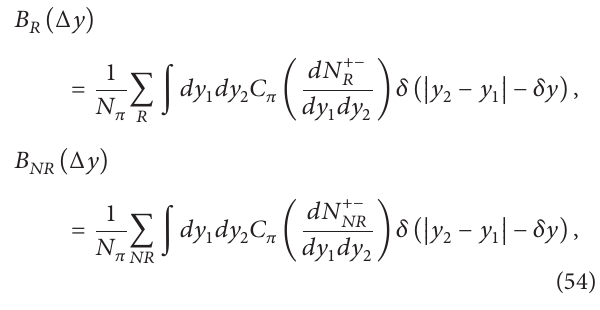
Figure 13: 𝜋 + 𝜋 − balance functions for RQMD are shown for both p+p and Au+Au collisions assuming a perfect detector. In contrast to the experimental results of [25], the balance functions are slightly broader for central Au+Au collisions. The graph is taken from [39].